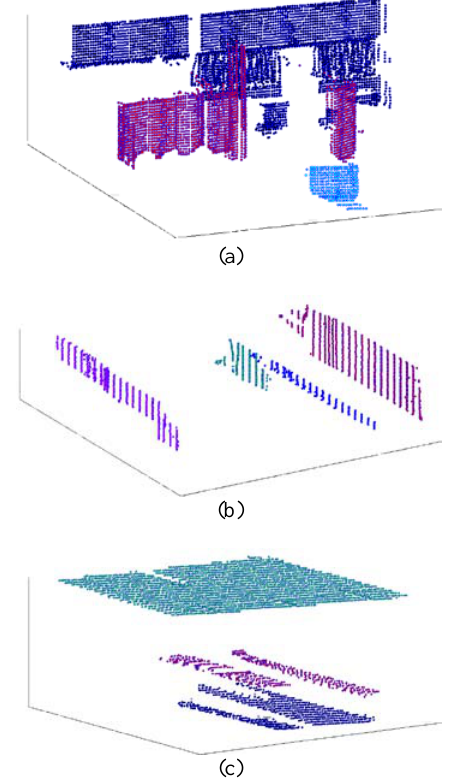
Figure 7. Points classified in the different planes for each direction; in descending order: (a) main wall, (b) side wall, and (c) horizontal surfaces.